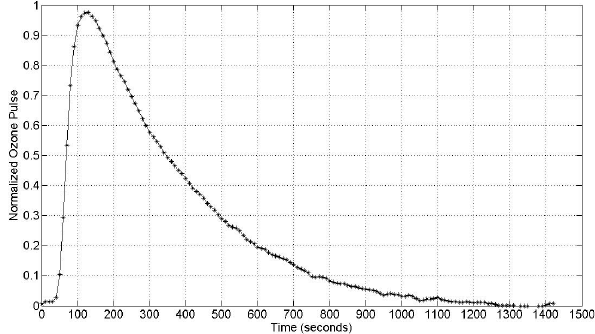
Fig. 2. Normalized mean ozone pulse for a series of four pulse experiments. A 20-s O 3 pulse was added at time=0s and O 3 was monitored at the output of the chamber. The pulses are normalized so that the peak value is